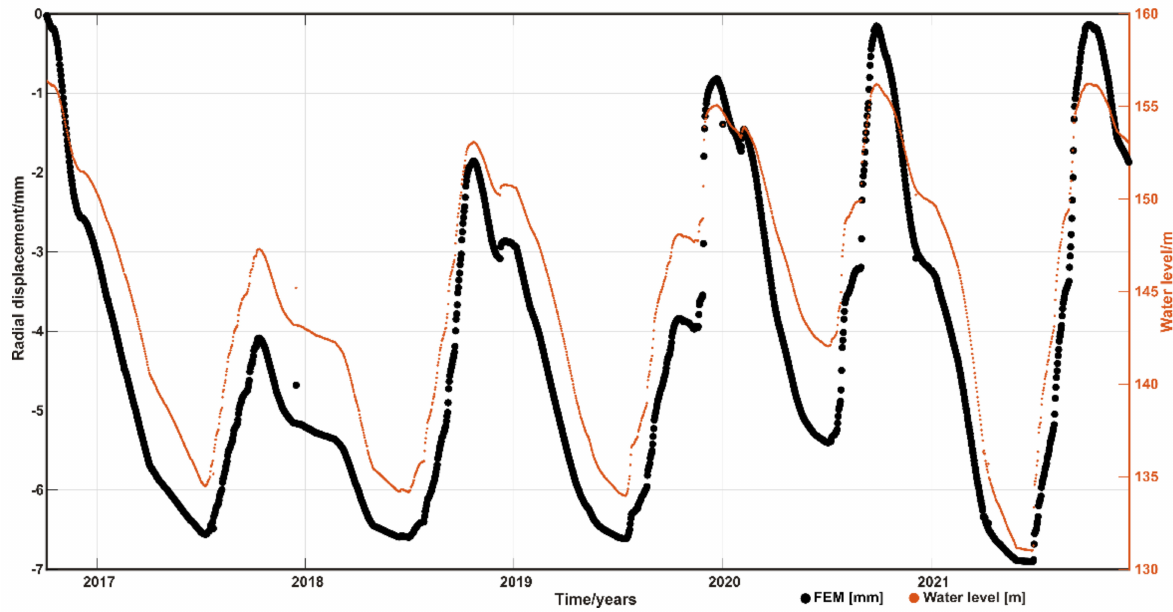
Figure 10. Comparison of the simulated radial displacements with the mathematical model of the dam and the reservoir